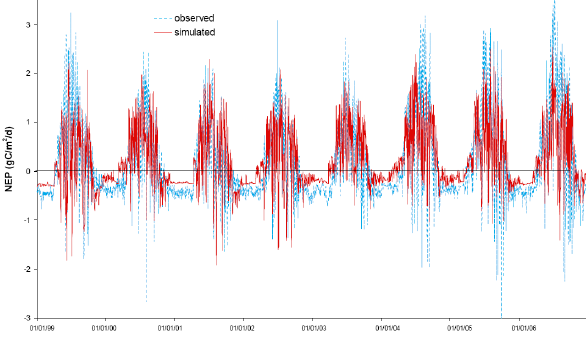
Fig. 4. The time series of hourly measured (blue dashed line) and simulated (red solid line) NEP for 1999–2006.